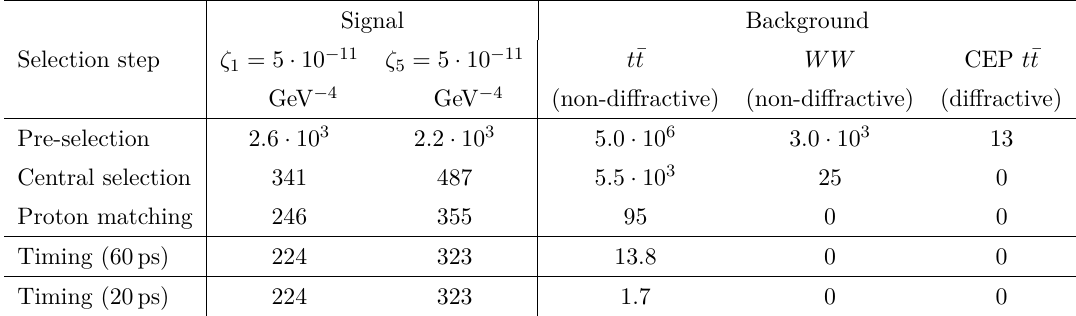
Table 2. Expected events for 300 fb − 1 at each of the selection steps, for the representatives of the operator sets O , O and for backgrounds. All other couplings are fixed to zero. Differences 1 ... 4 5 ... 6 among samples of the same family are within Monte Carlo statistical